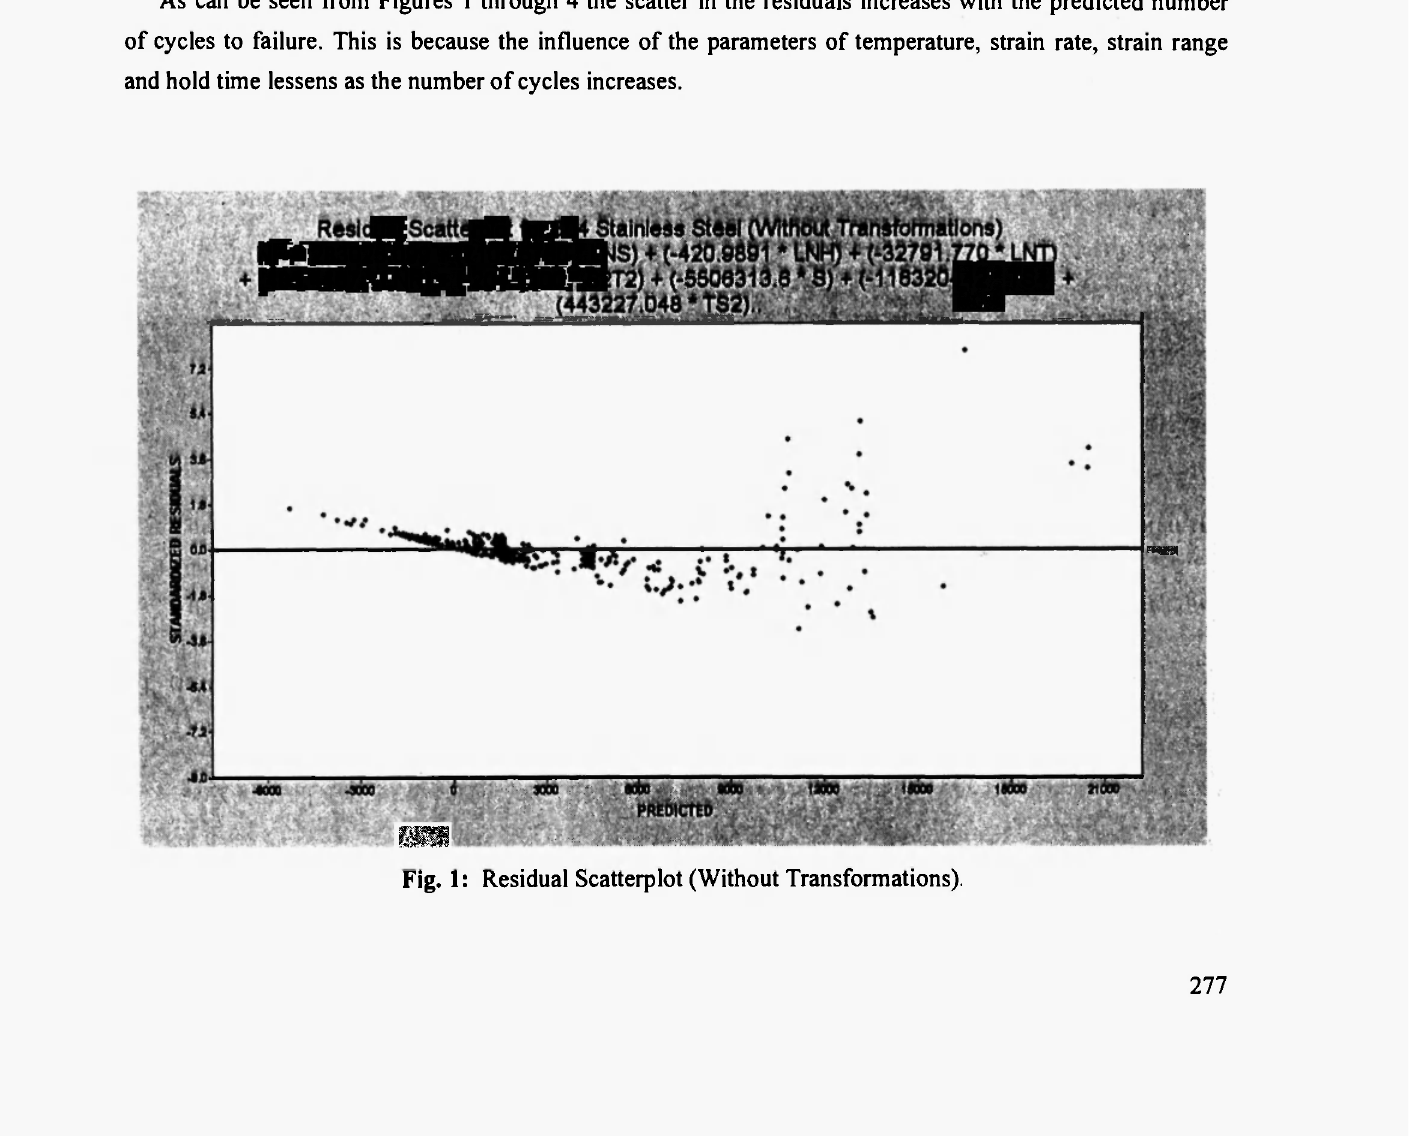
Fig. 1: Residual Scatterplot (Without